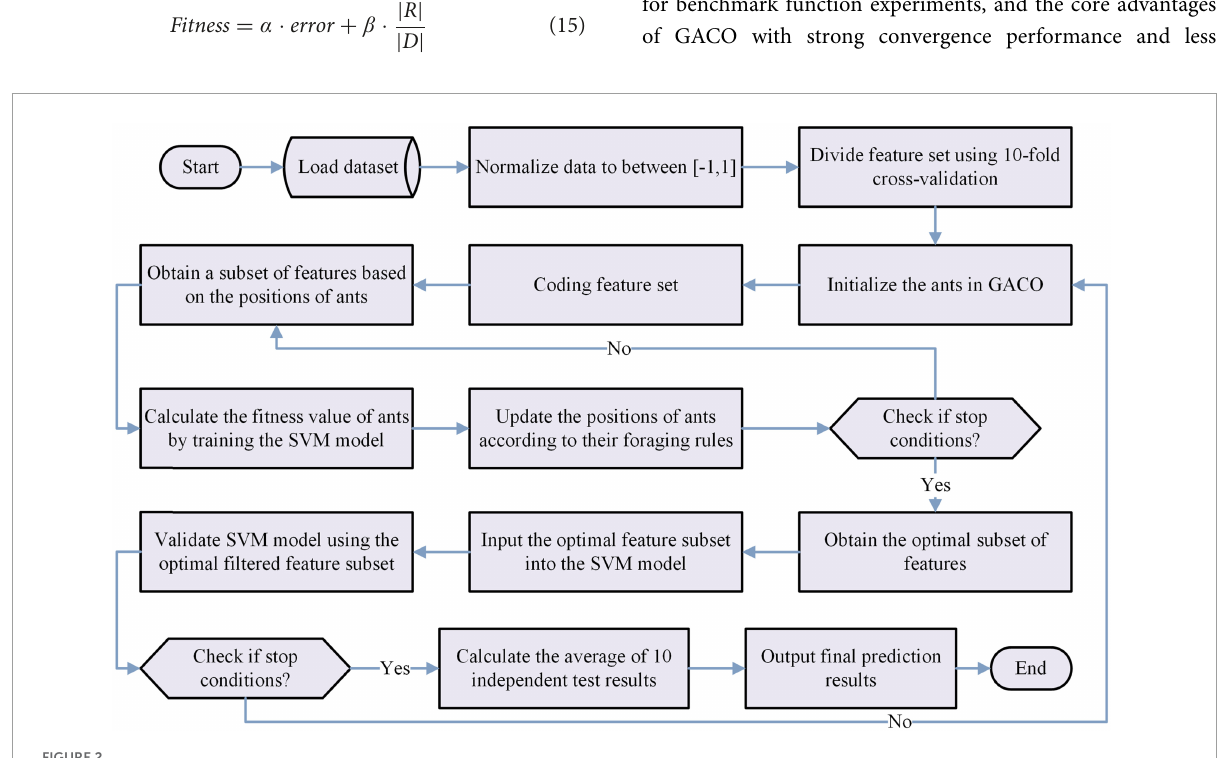
FIGURE2 Flow chart of the bGACO-SVM